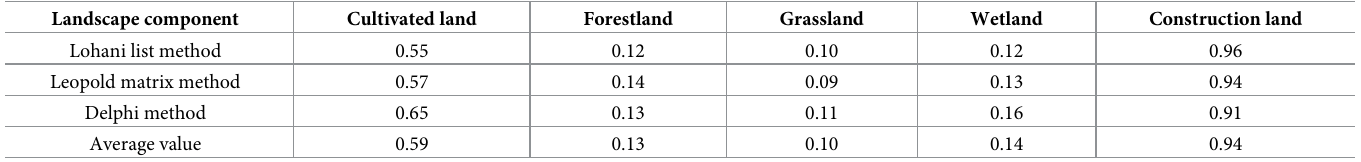
Table 3. Strength indices of human impact for different landscape elements. Landscape